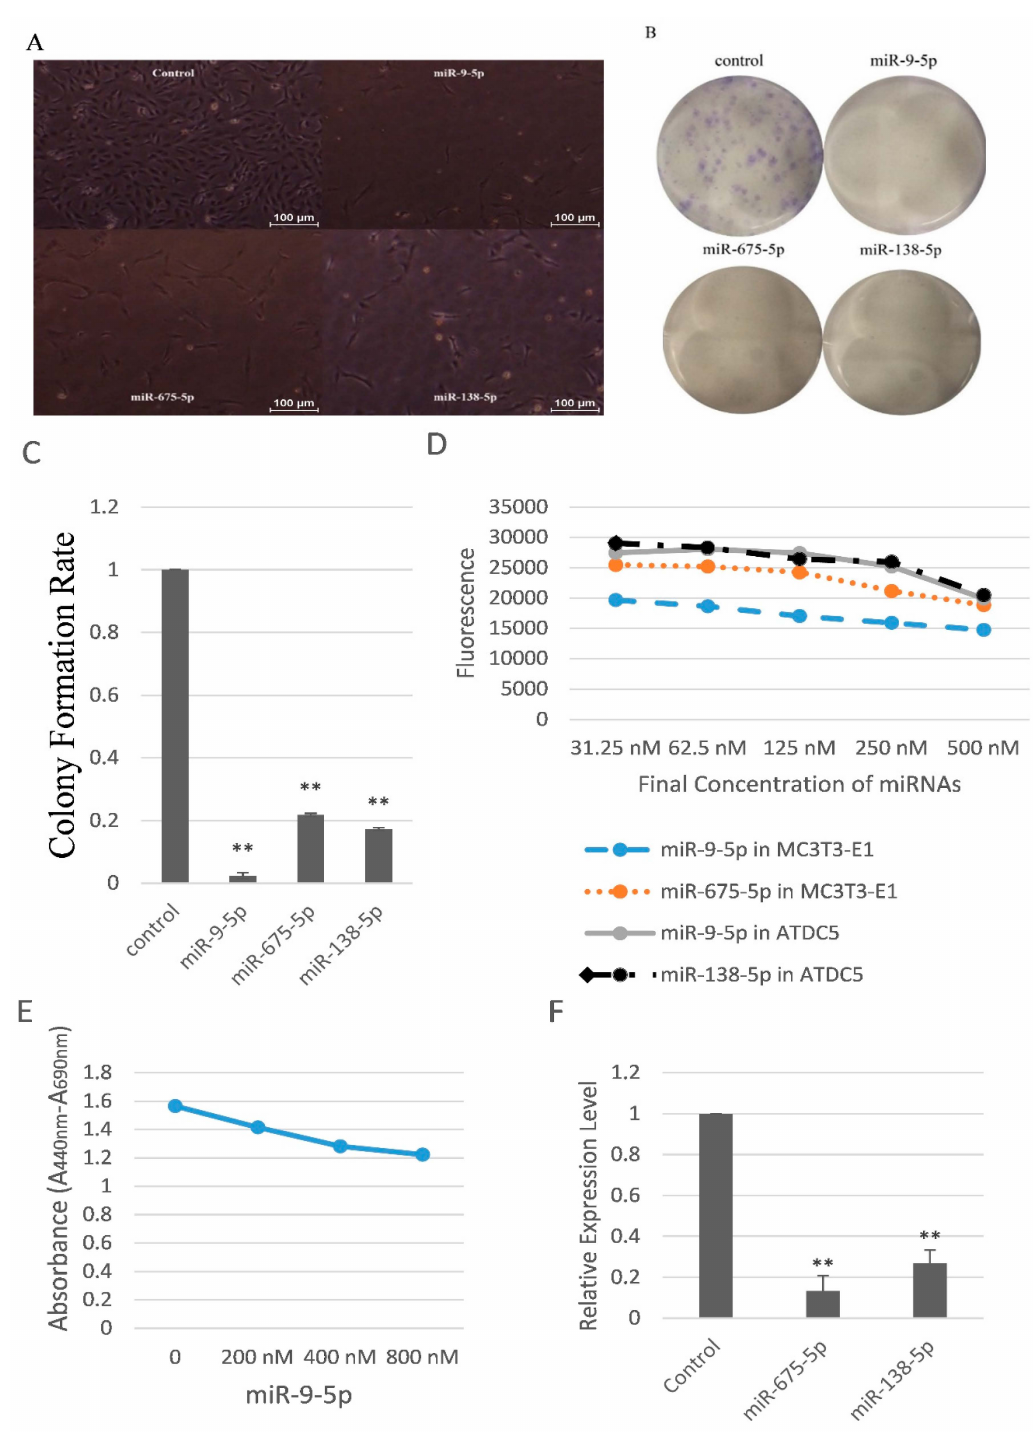
Figure 2. miR-9-5p, miR-675-5p, and miR-138-5p reduced skeletal cell count and cell proliferation. ( A ) Representative photos of MC3T3-E1 cells transfected with miR-9-5p, miR-675-5p, and miR-138-5p; ( B ) Representative pictures of clonogenic assay with miR-9-5p, miR-675-5p, and miR-138-5p; ( C ) The clonogenic potential of MC3T3-E1 transfected with miR-9-5p, miR-675-5p, and miR-138-5p; ( D ) Fluorescence changes of MC3T3-E1 transfected with miR-9-5p and miR-675-5p, and ATDC5 transfected with miR-9-5p and miR-138-5p; ( E ) Determination of the cytotoxic activity of miR-9-5p on MC3T3-E1 cells; ( F ) Expression levels of PCNA in MC3T3-E1 cells upon transfection of miR-675-5p and miR-138-5p ** p < 0.01. n =